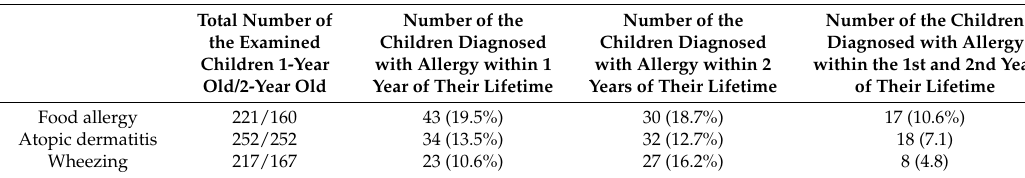
Table 2. The children’s health status.